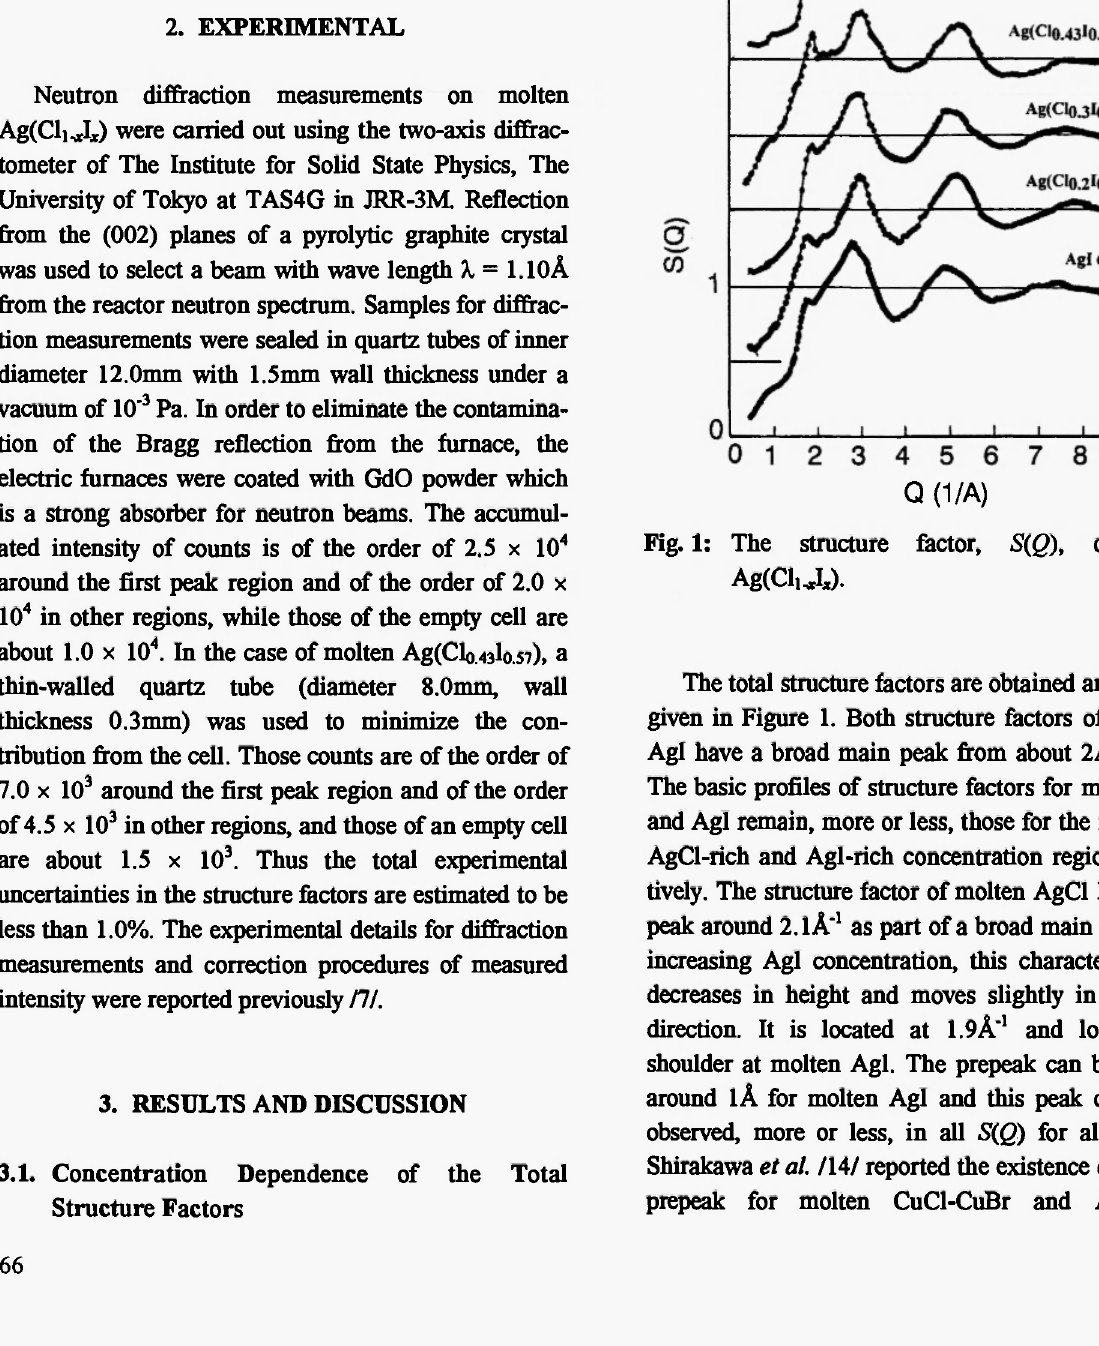
Fig. 1: The structure factor, 5(0, of molten